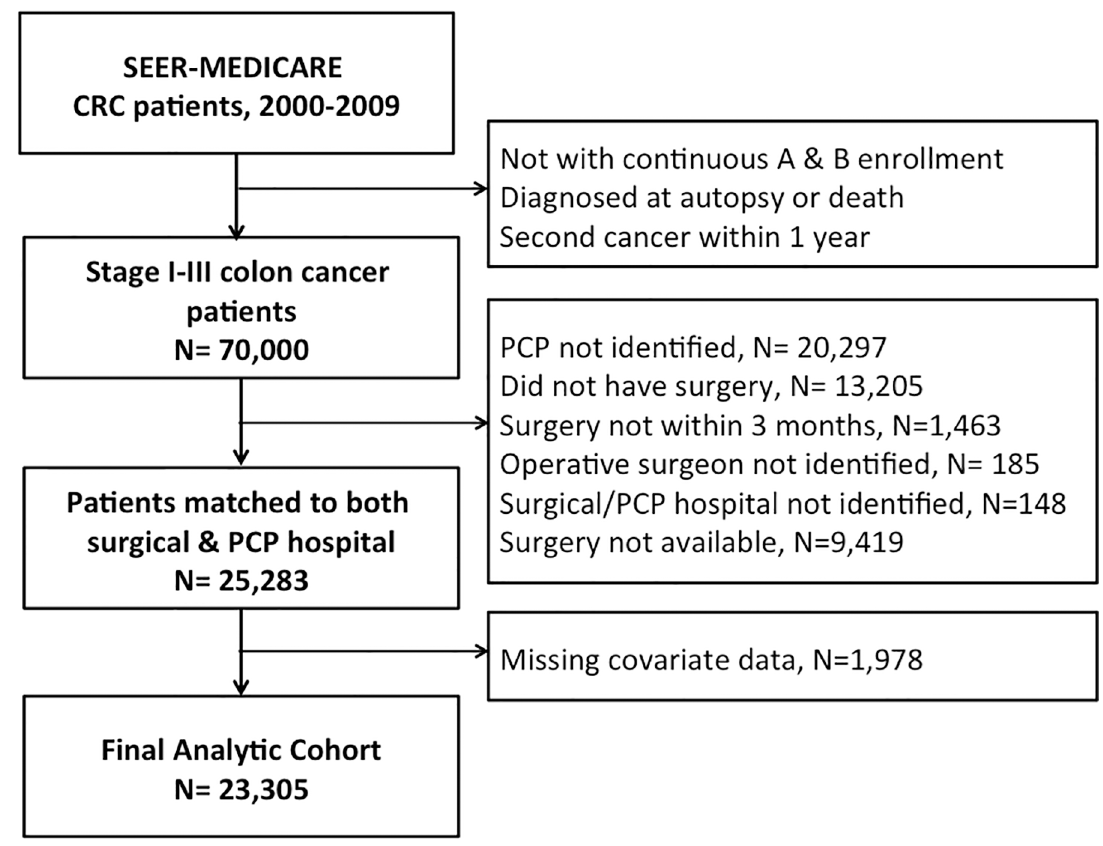
Fig 1. Flow chart of inclusions & exclusions for analytic